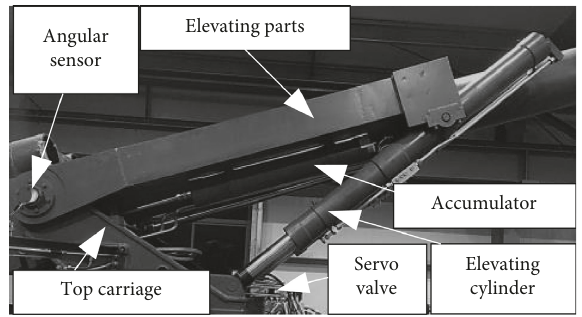
Figure 1: Experimental test rig of